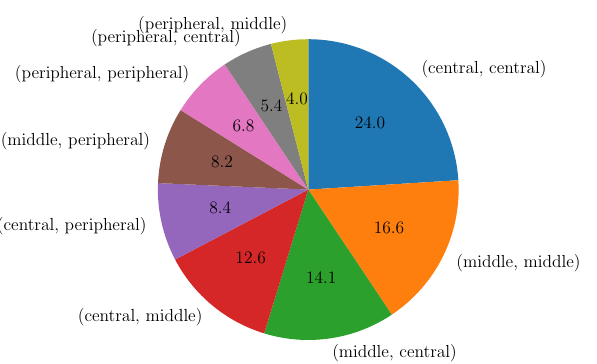
Figure 10. Number of trips classified according to three-zone division with respect to total number of